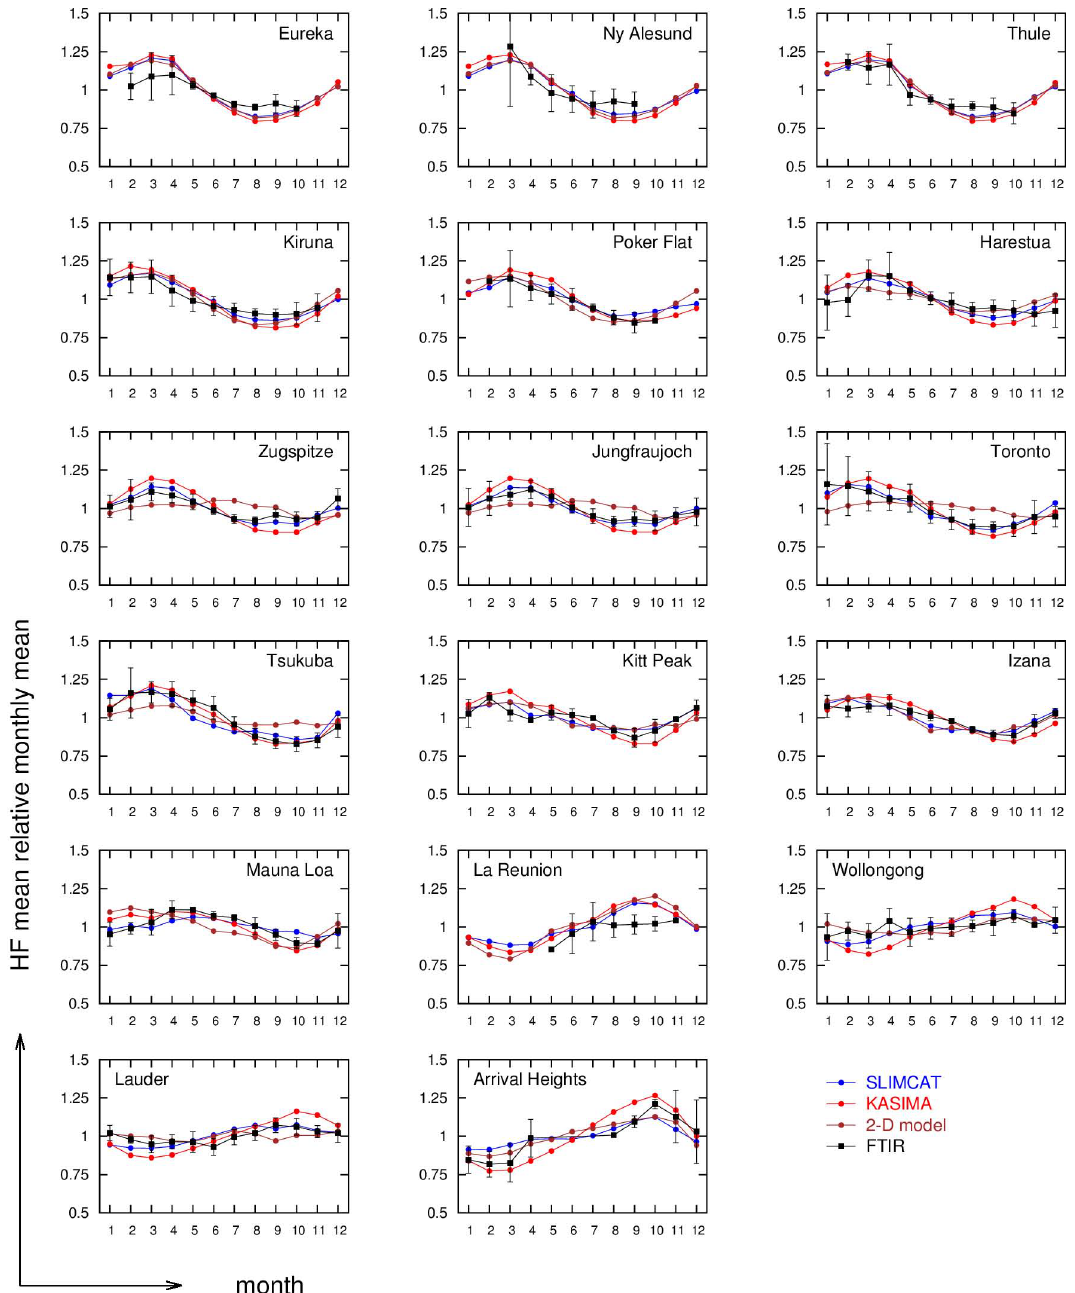
Fig. 8. Annual cycle of HF at the different sites as determined from the FTIR instruments (black) and simulated by SLIMCAT (blue), KASIMA (red), and the Bremen 2-D model (brown). The mean relative monthly means were calculated by normalising the monthly means with the respective annual mean and then averaging over the period 2000–2009. The error bars of the FTIR measurements represent the standard